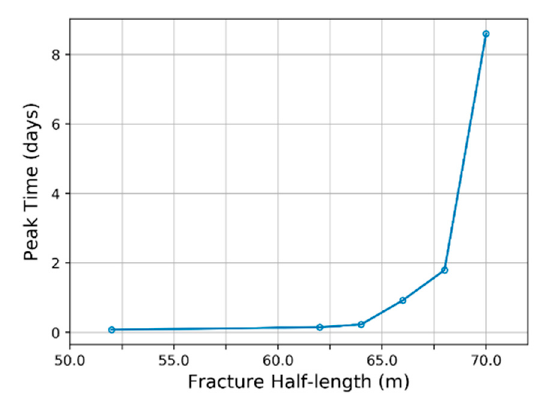
Figure 8. Time at which peak tracer concentration is observed increases with an increase in the fracture length.